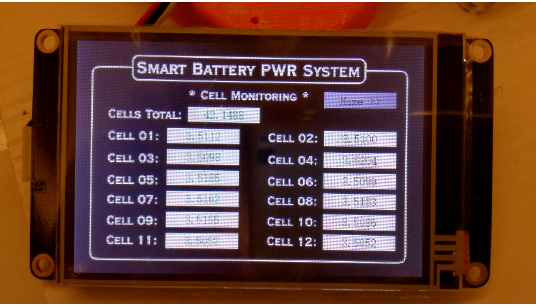
Figure 12. Cell-monitoring panel of GUI for proposed battery-power system. Energies 2017 , 10 , 1503